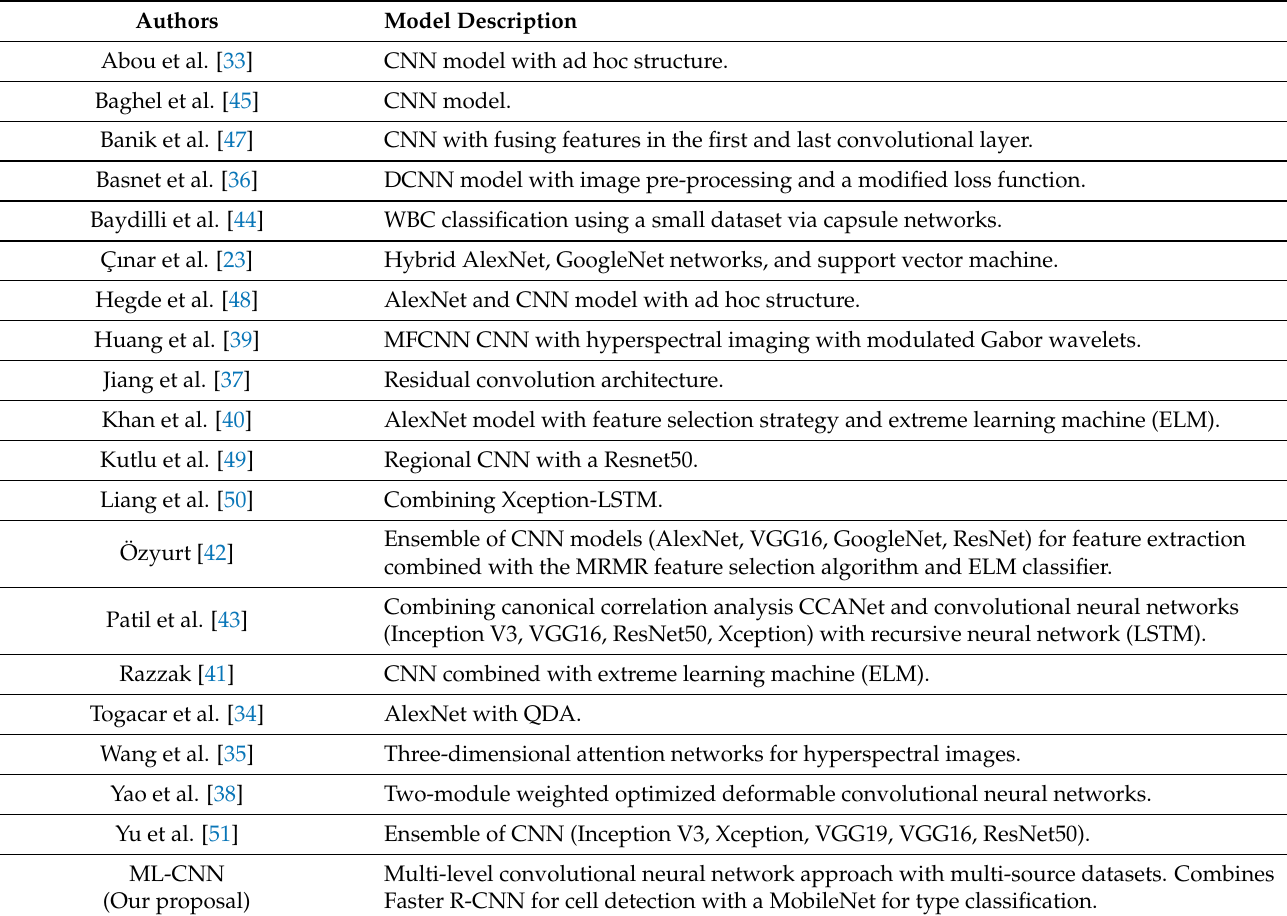
Table 1. Summary of the state-of-the-art models for white blood cells